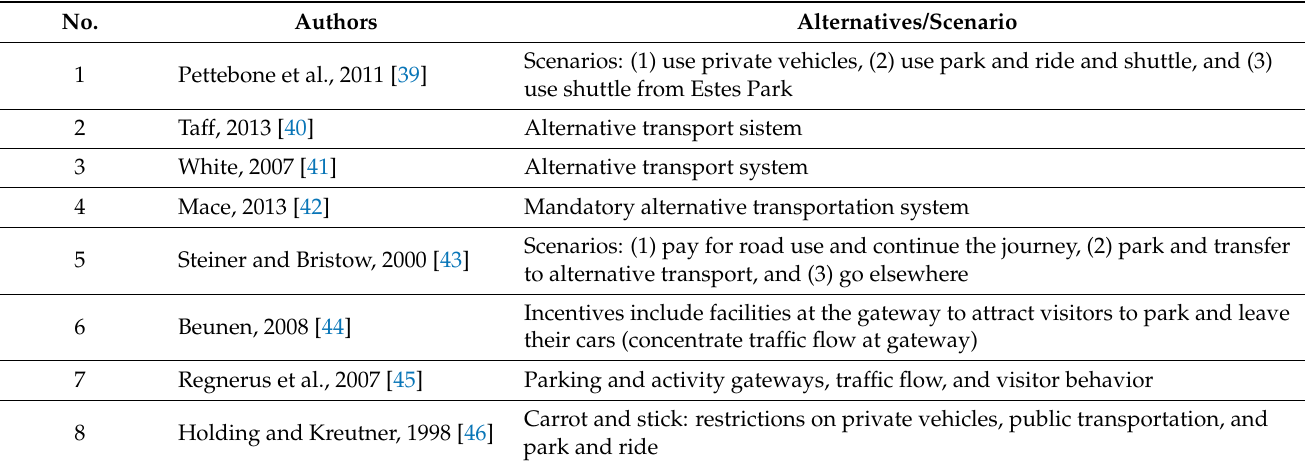
Table 1. Transportation policies in natural tourism